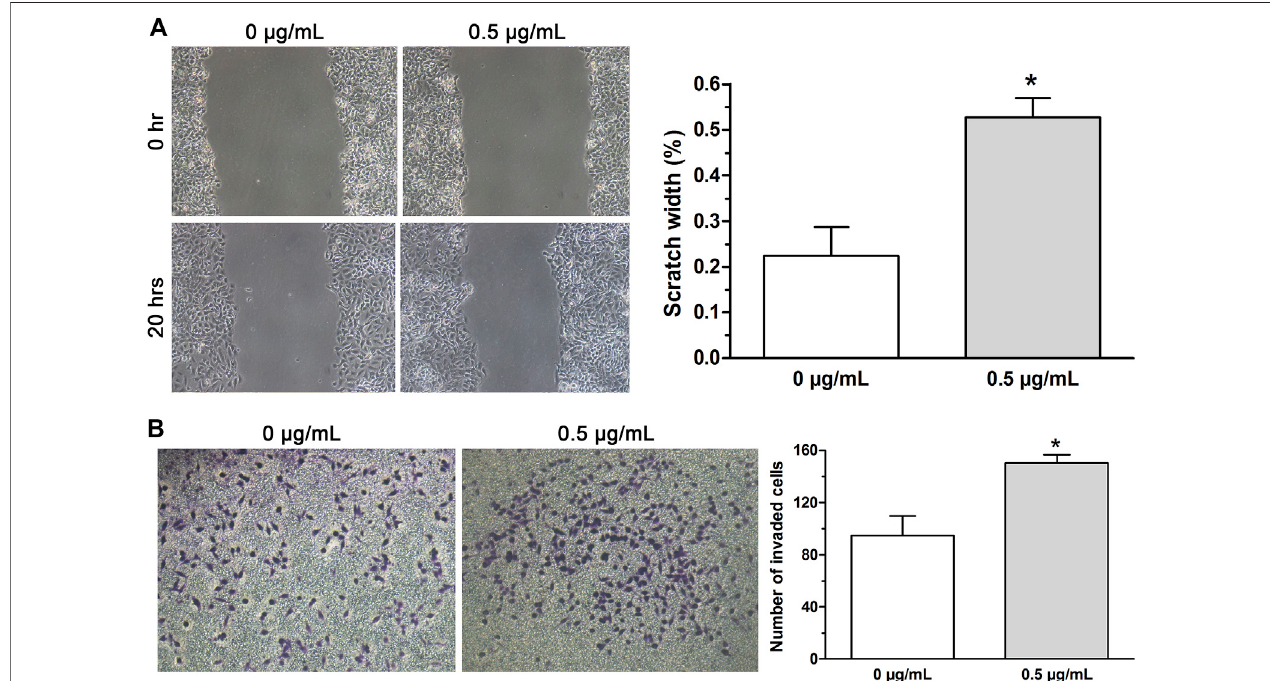
FIGURE3| EMTprogressionofA549cellspromotedbylow-dosecisplatintreatment. (A,B) MigrationandinvasionofA549cellsweremeasuredbywoundhealing assayandtranswellinvasionassay,respectively.ThemigrationandinvasiveabilityofA549cellstreatedwithlow-dose(0.5 μ g/ml)cisplatinwasincreasedcomparedwith that of controls (* p < 0.01). All pictures were photographed at a magni fi cation of ×100, scale bar = 100 um. Each experiment was conducted in triplicate and the data were expressed as mean ±